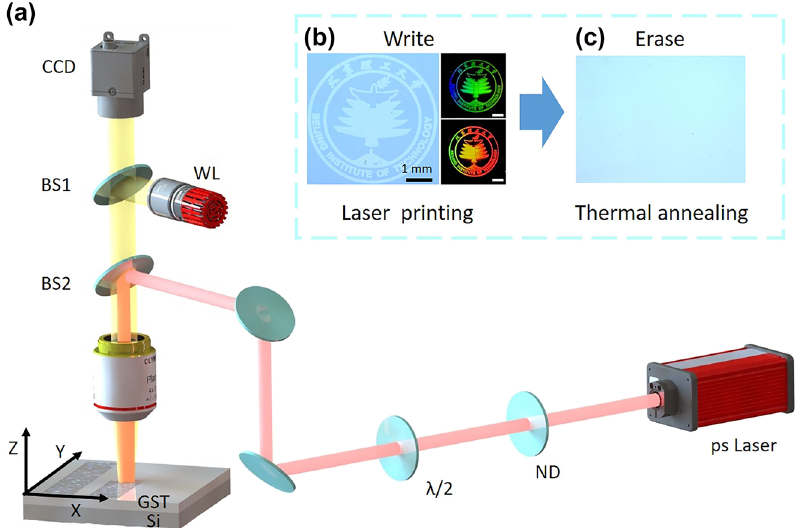
displayed and colored micrographs displayed. Figure